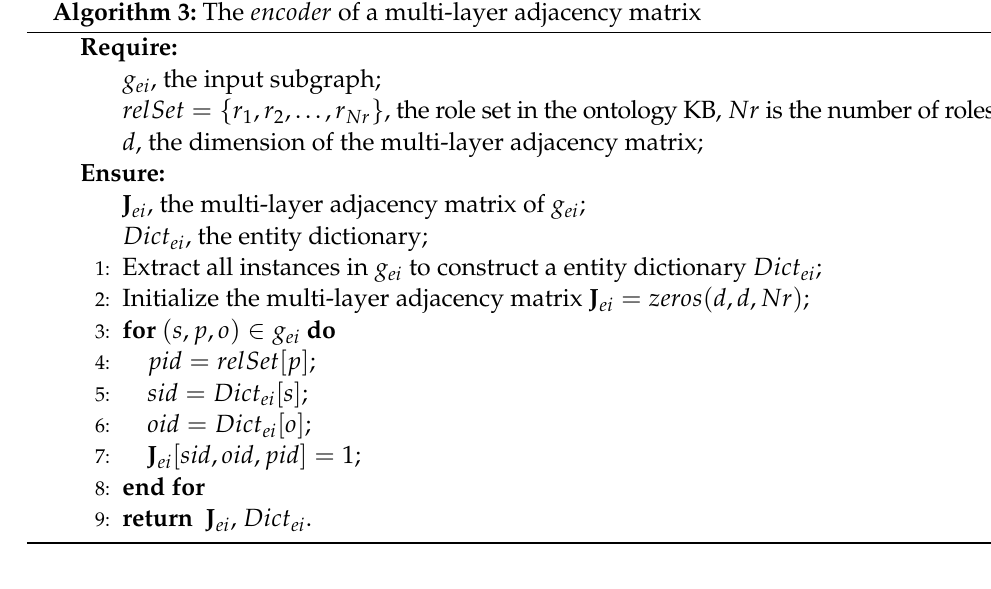
Algorithm 4: The decoder of a multi-layer adjacency